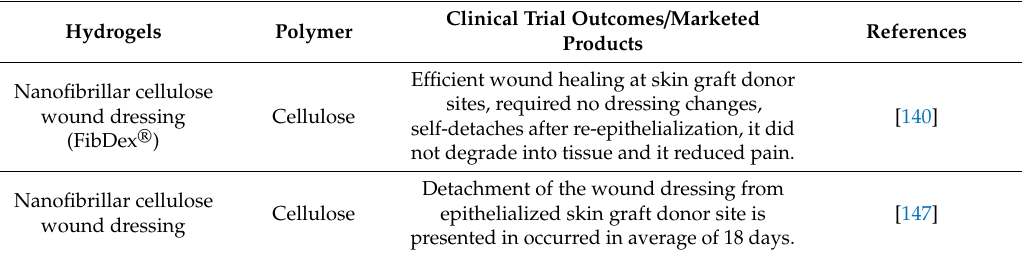
Table 2. Hydrogels in clinical trials / marketed